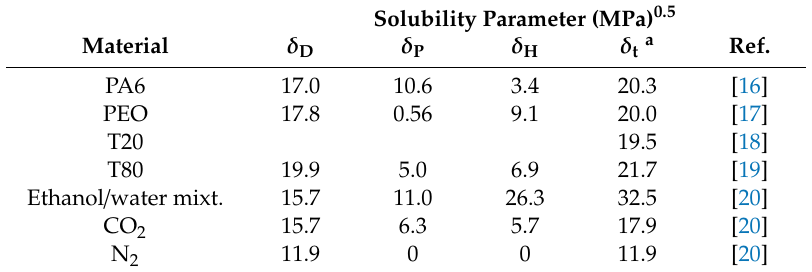
Figure 2. Average size of the aggregates in the Pebax ® 1657 (control) and Pebax ® 1657 / polysorbate 50 / 50 solutions determined via dynamic light scattering (DLS) analysis. Table 2. Hansen solubility parameters (HSPs) of Pebax ® 1657, T20, T80, ethanol / water mixture, and some